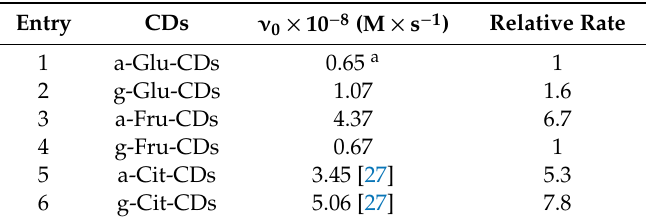
Figure 6. Reaction kinetics of formation of MV • + using CDs as photo-redox catalysts. Reaction conditions: MV 2 + 60 µ M, EDTA 0.1 M, λ exc : 365 nm with an absorbance-normalized amount of CDs and water as solvent (see Supplementary Materials for more details). Table 2. Photocatalytic performance of the tested